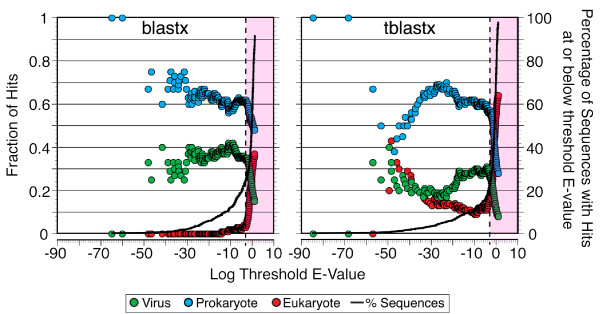
Changes in the distribution of blastx and tblastx hits as a function of E-value threshold. The proportion of top-scoring matches to viruses (including bacteriophages), prokaryotes, or eukaryotes is plotted as a function of the E-value threshold for blastx (left panel) or tblastx (right panel). The vertical dashed line represents the frequently used threshold of 10-3, beyond which hits would not be considered significant (pink shaded region). The solid line in each graph shows the cumulative percentage of sequences that lie at or below a given E-value threshold.